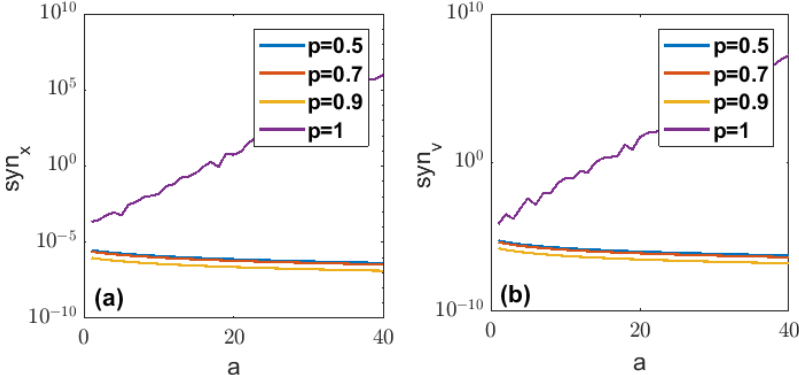
Figure 7. The average synchronization error 𝑆𝑦𝑛 𝑥 ( a ) and 𝑆𝑦𝑛 𝑣 ( b ) as functions of the potential